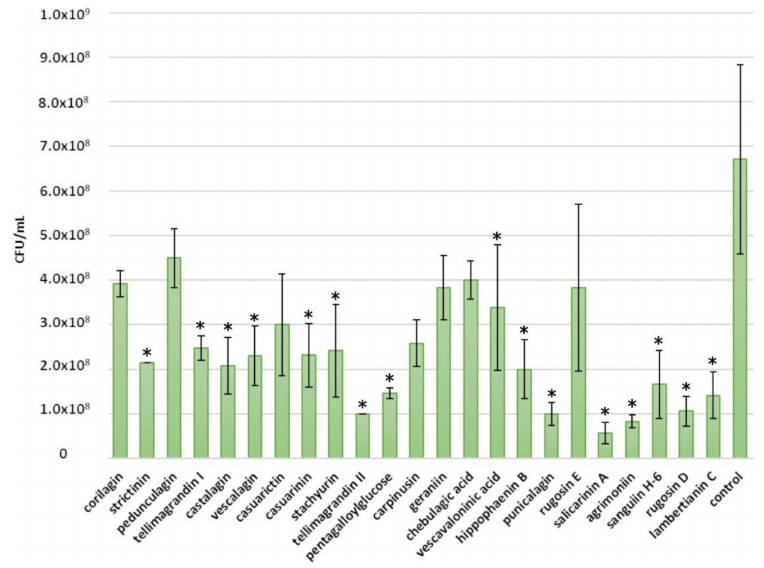
Figure 6. Growth of Clostridiales perfringens after a 24 h treatment with 0.5 mM ellagitannin and pentagalloylglucose solutions. Growth is expressed as CFU / mL (mean values and standard deviations, n = 3). All tested tannins are in the order of increasing molecular weight; * p <